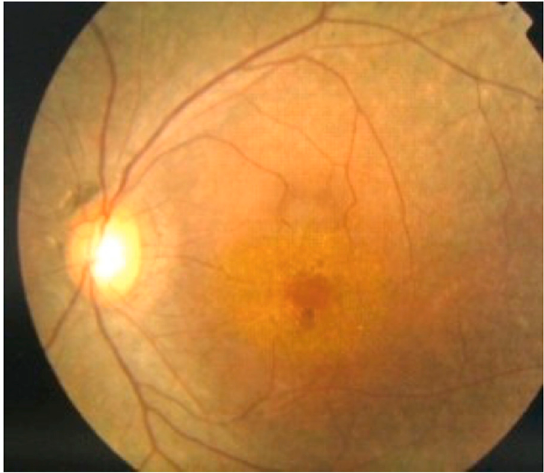
Figure 3. Retinitis pigmentosa in MPS II. Fundoscopy showing retinitis pigmentosa in a 39-year-old MPS II patient.